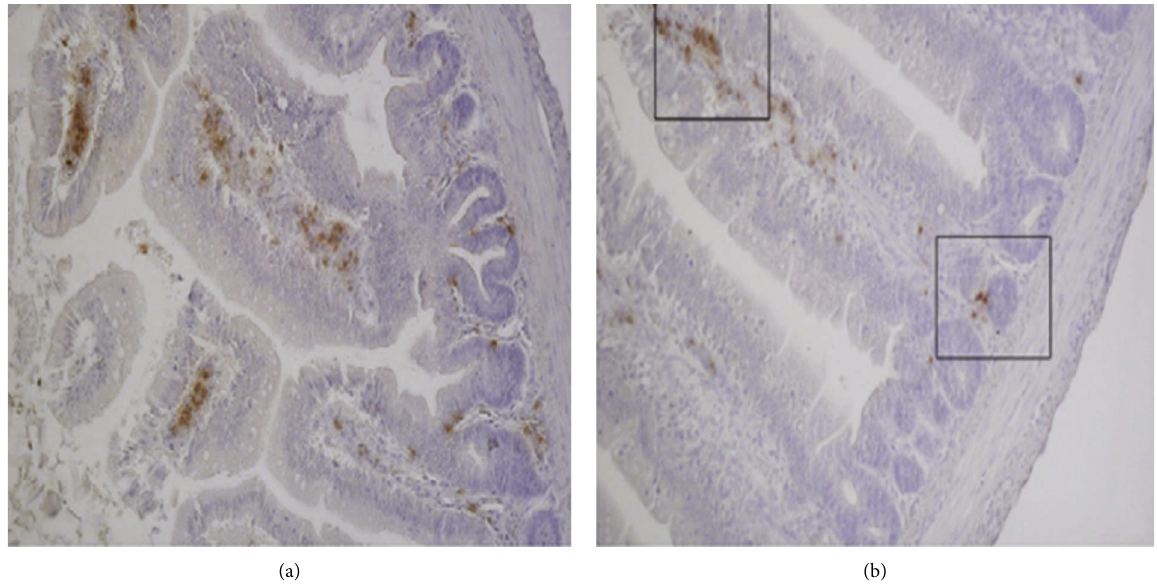
Figure 3: Localization of CATH-2 in jejunal tissues of S. enteritidis -infected chicken. Chickens were infected with 1 × 104 CFU nalidixic- resistant S. enteritidis PT4. Jejunum tissue sections from infected and control chickens were taken 8 and 48h after infection and were applied with Giemsa stained followed by immunostaining with anti-CATH-2 antibody. Massive infiltration of CATH-2 positive cells occurred in jejunal villi lamina propria of infected chickens at 8 h (a) and lesser extent at 48h (b)